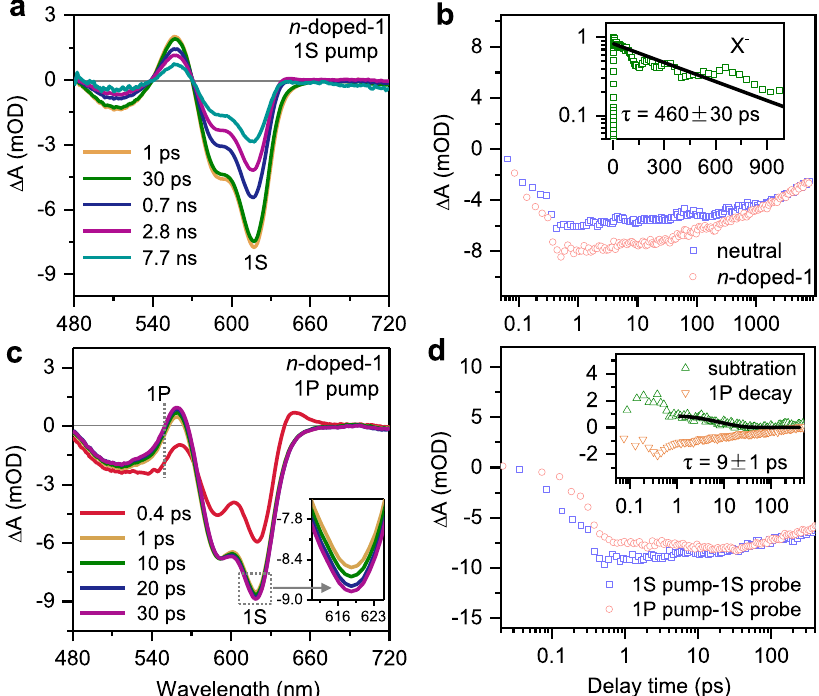
Fig. 4 Spin blockade in lightly n -doped QDs. TA spectra of n -doped-1 probed at indicated time delays following excitation at a 1S e -1S 3/2,h and c 1P e -1P 3/2,h transitions by 624 and 547 nm pulses, respectively. Inset in c is an enlarged view of the slowly growing 1S bleach feature. b TA kinetics probed at the 1 S bleach for n -doped-1 (red circle) and neutral (blue square) samples, scaled at their slowly-decaying tail, in the case of 1S e -1S 3/2,h excitation. Inset is the Auger recombination kinetics (green square) obtained by performing a subtraction between the two traces in the main panel and its single-exponential fi t to a time constant of 460 ps. d TA kinetics probed at the 1 S bleach for n -doped-1 under 1S e -1S 3/2,h (blue square) and 1 P e -1P 3/2,h (red circle) excitations, scaled at their slowly-decaying tail. Inset are the 1S kinetics obtained by performing a subtraction between the two traces in the main panel (green triangle) and the kinetics monitored at the 1P bleach (orange triangle). Black solid line is a fi t to the slow relaxation component with a time constant of 9 ps indicative of a spin